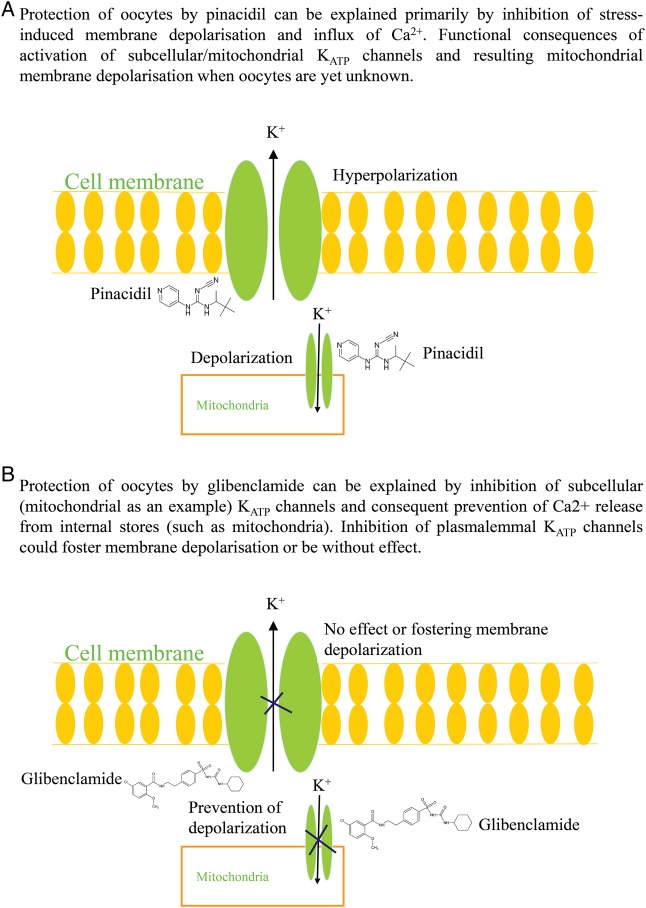
A possible mechanism underlying cytoprotective action of pinacidil and glibenclamide in human oocytes. Cartoon summarizing possible underlying mechanisms mediating pinacidil- (A) and glibenclamide-induced (B) cytoprotection in MII human oocytes based on the findings from the present study as well as findings from previous studies that have investigated KATP channels in oocytes and other cell types (Brady et al., 1996; Holmuhamedov et al., 1998; Jovanović et al., 1999; Jovanović and Jovanović, 2001; Du et al., 2010).